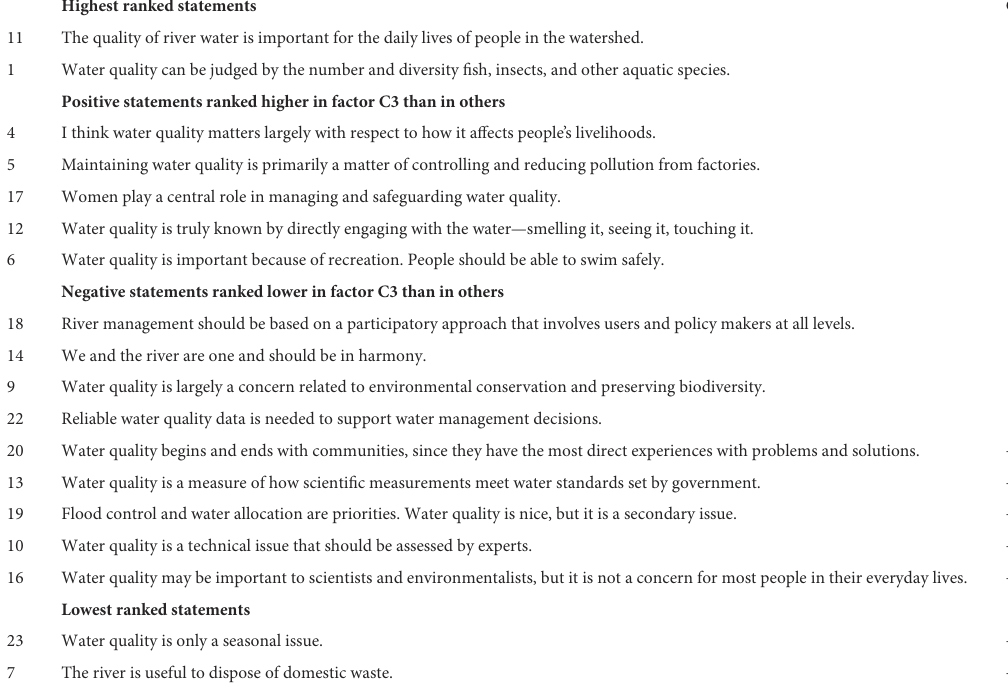
TABLE 4 Example crib sheet for Q1, Concept , factor